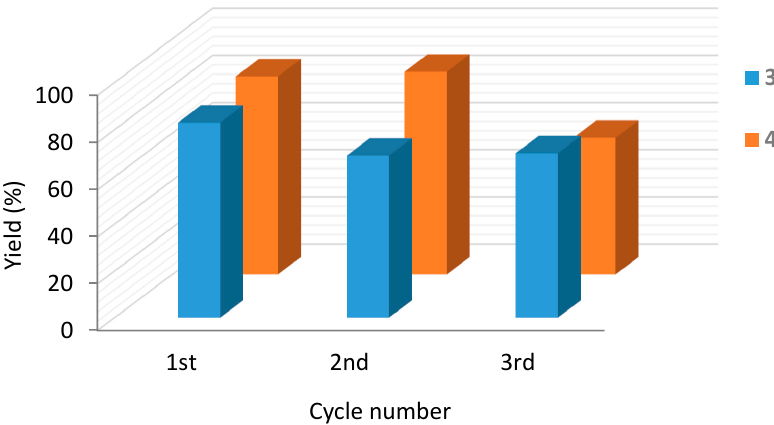
Figure 9. Recycling studies for 3 and 4 . Reaction conditions: 2.5 mmol of substrate, 2.5 mmol of t -BuOOH (aq. 70%), TEMPO additive (2.5 mol %), 80 °C, 3 h, microwave irradiation (5 W).